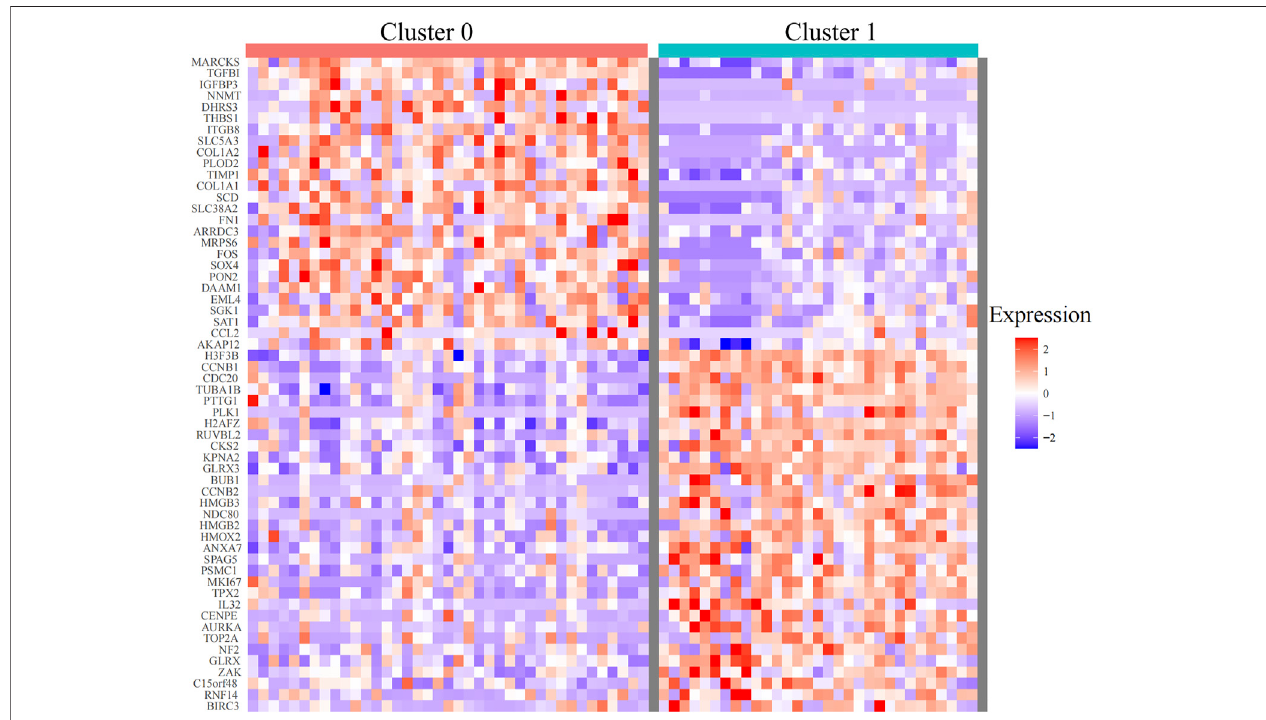
FIGURE 6 | Heatmaps of differentially expressed genes between cluster 0 and cluster 1 identi fi ed by TSNE analysis (with adjusted p < 0.05). TSNE, t-Stochastic Neighbor Embedding.